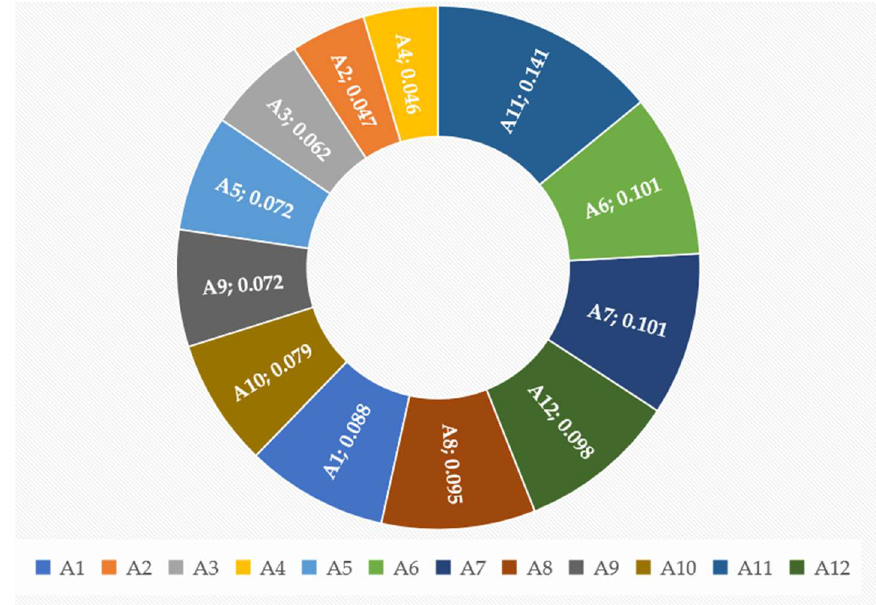
Figure 5. Final ranking of the siting alternatives for HOWiWaES in Greece. 392